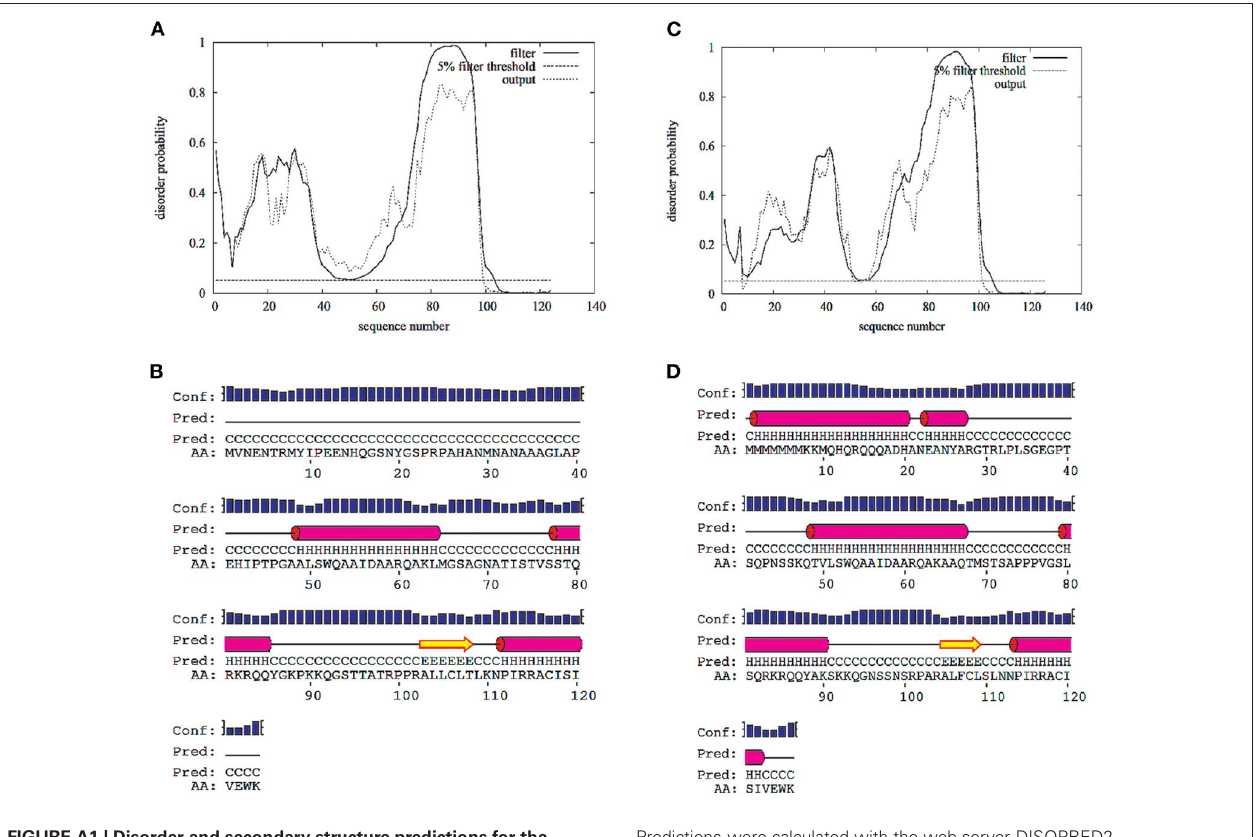
FIGURE A1 | Disorder and secondary structure predictions for the N-terminal cytoplasmic domain of the L-type voltage-gated calcium channel Ca v 1.2 (1–124 AAs)(A,B) and Ca v 1.3 (1–126) (C,D).